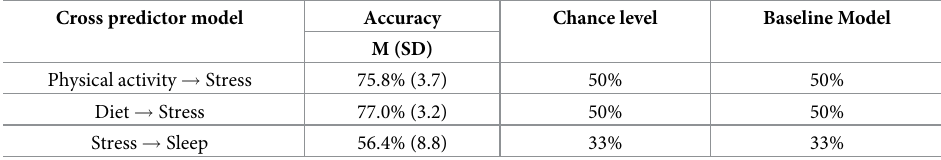
Table 4. SVM mean classification accuracies and chance levels for three cross predictor models.